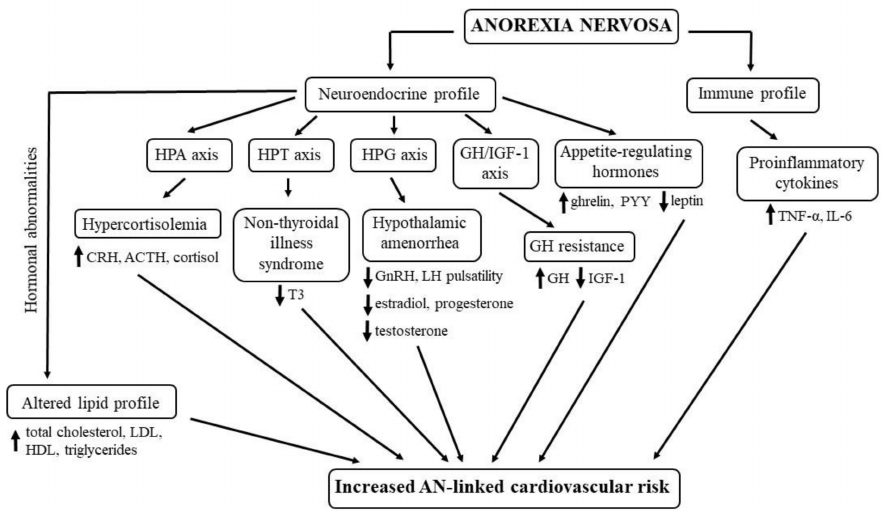
Figure 1. The complex neuroendocrine–immune pathways leading to a higher risk of cardiovascular diseasesinanorexianervosa. HPA,hypothalamic–pituitary–adrenal; HPT,hypothalamic–pituitary–thyroid; HPG, hypothalamic–pituitary–gonadal; GH, growth hormone; IGF-1, insulin-like growth factor 1; CRH, corticotropin-releasing hormone; ACTH, adrenocorticotropic hormone; T3, triiodothyronine; GnRH, gonadotropin-releasing hormone; LH, luteinizing hormone; PYY, peptide YY; TNF- α , tumour necrosis factor α ; IL-6, interleukin 6; LDL, low-density lipoprotein; HDL, high-density lipoprotein; AN, anorexia nervosa; up-arrow, increased levels; down-arrow, decreased